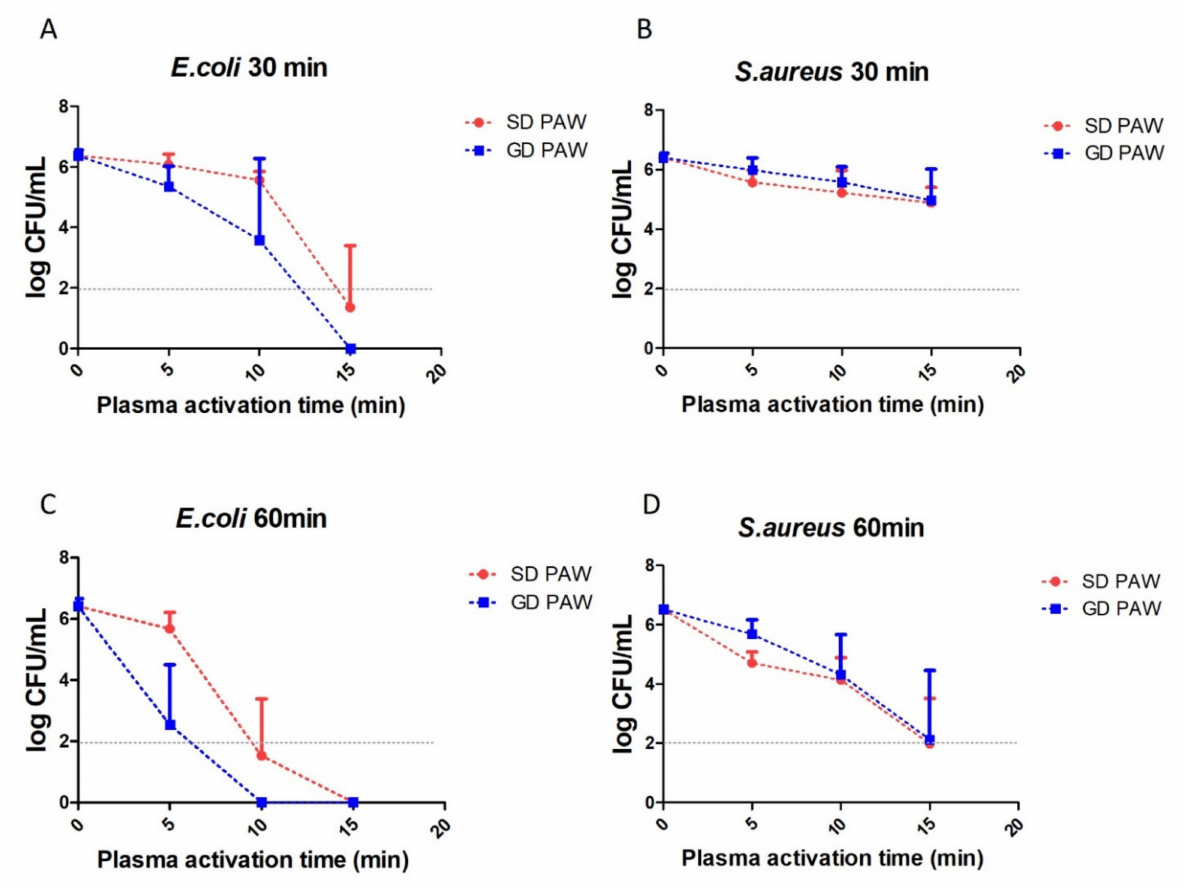
Figure 4. Bactericidal stability of PAW after 5, 10, or 15 min plasma activation, made by spark and glow discharges on E. coli and S. aureus with 30 and 60 min contact time a week after PAW generation. ( A ) E. coli —30 min; ( B ) S. aureus —30 min; ( C ) E. coli —60 min; ( D ) S. aureus —60 min (data shown as mean ± SD, average of three experiments). Limit of detection: 2 log 10 CFU/mL.